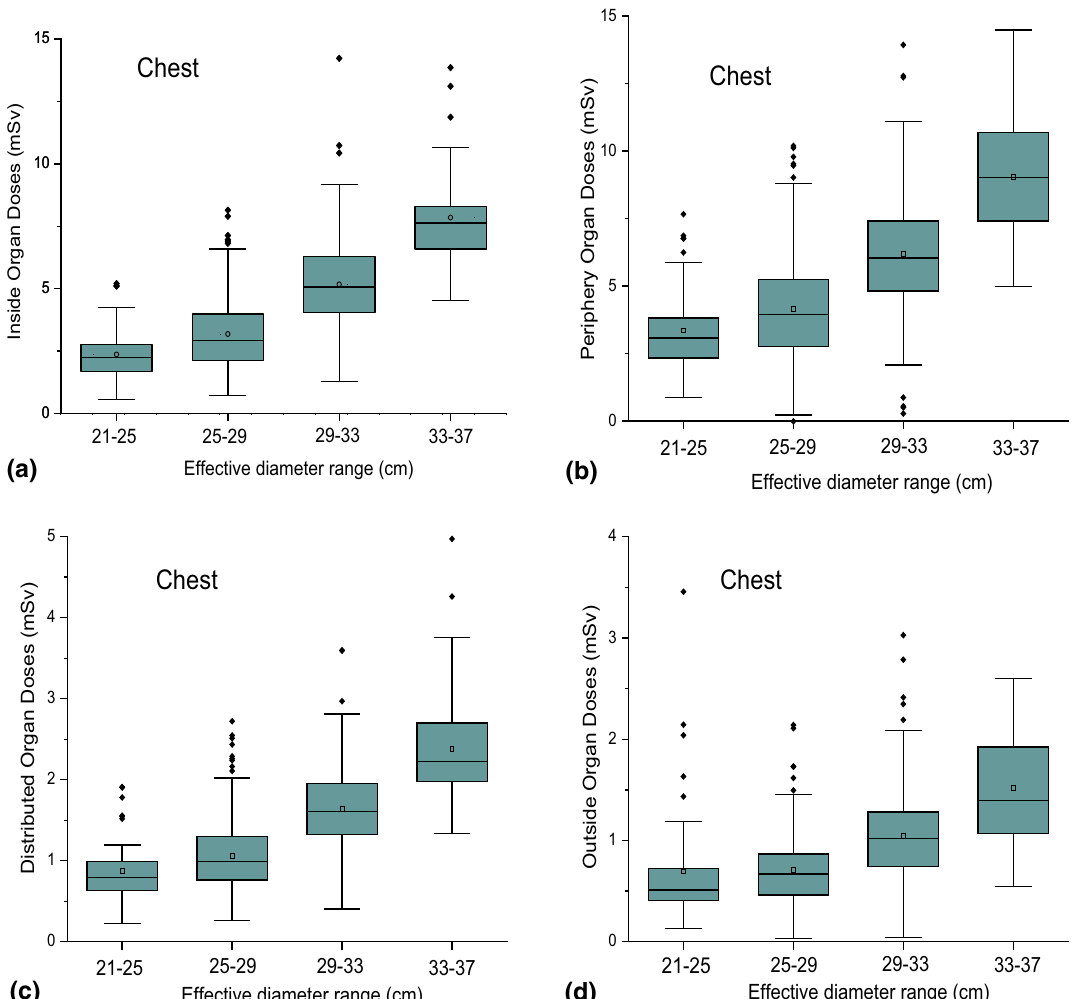
Fig. 2 Box-plots representing the distributions of the organ dose groups: a IO, b PO, c DO and d OO, according to the effective diameter group ranges for chest examinations